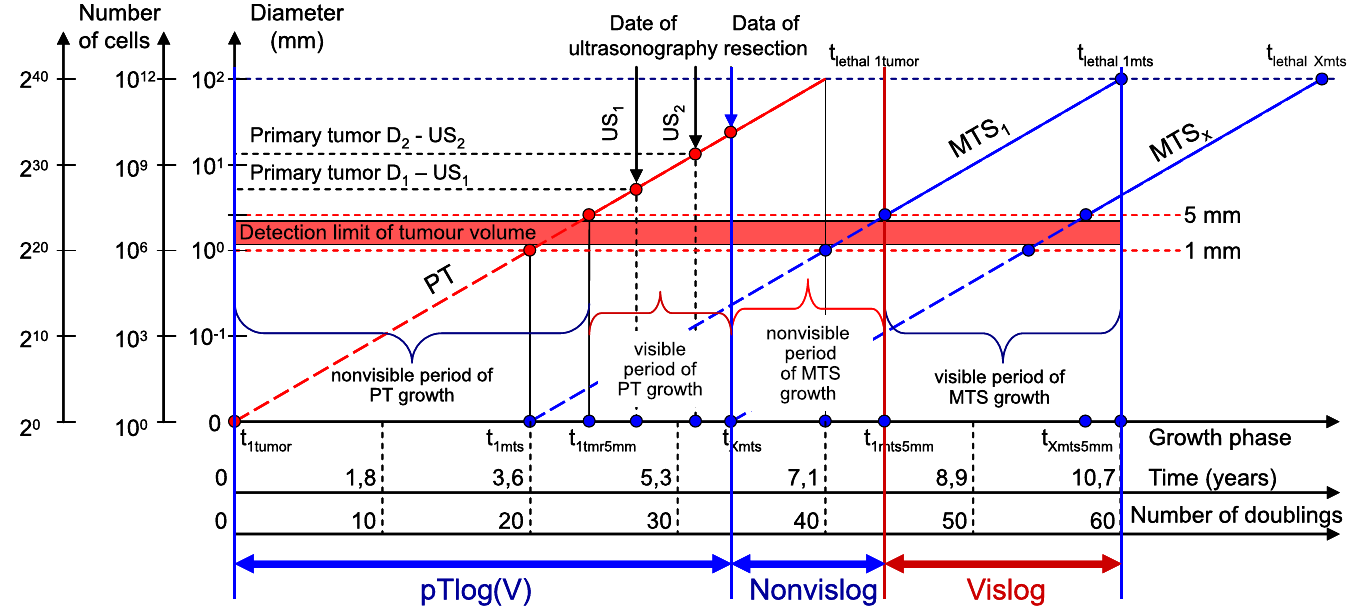
Fig 2. Scheme of the whole natural history of BC. The main feature is that model describes PT growth and secondary distant MTS growth as a whole (as indivisible dependent process). pT log( V )–the number of PT doublings; Nonvislog –the number of doublings for non-visible growth period of MTS; Vislog –the number of doublings for visible growth period of MTS; 60 doublings–the whole nature growth history of PT and secondary distant MTS. Tumor volume doubling time (TVDT) of PT and secondary distant MTS means a mean period (65 days).